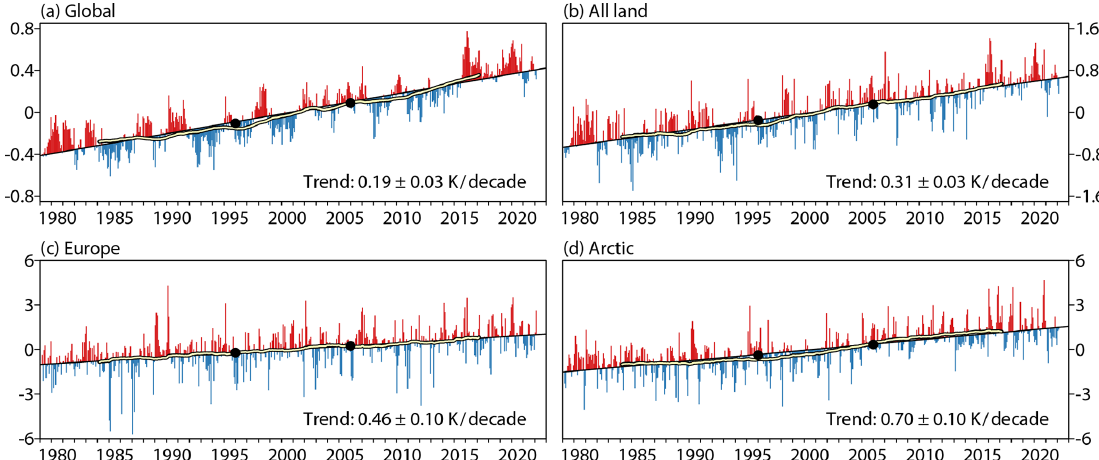
Figure 1. Monthly means of ERA5 2m temperature (K) averaged (a) globally, (b) over all land, (c) over Europe (defined as land from 20 ◦ W–40 ◦ E and 35–80 ◦ N) and (d) over the Arctic (defined as the whole area north of 66.6 ◦ N). Values are plotted from March 1979 to February 2022. They are shown relative to averages for each month of the year made over the period and plotted according to whether they are above (red) or below (blue) the least squares fit linear trend for the period. The black circles plotted at the ends of 1995 and 2005 show 30-year averages for 1981–2010 and 1991–2020. Yellow lines edged in black show 120-month running